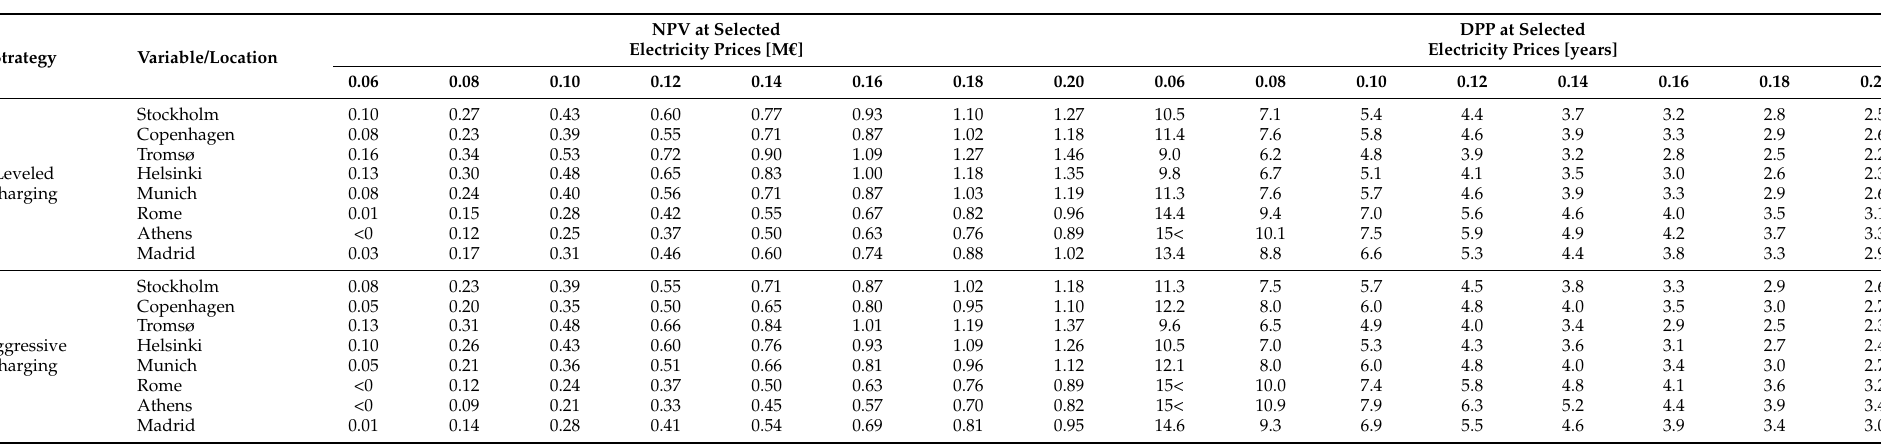
Table A3. Net present value (NPV) and discounted payback period (DPP) for selected cities with the PC design at different electricity prices when applying the leveled and aggressive charging